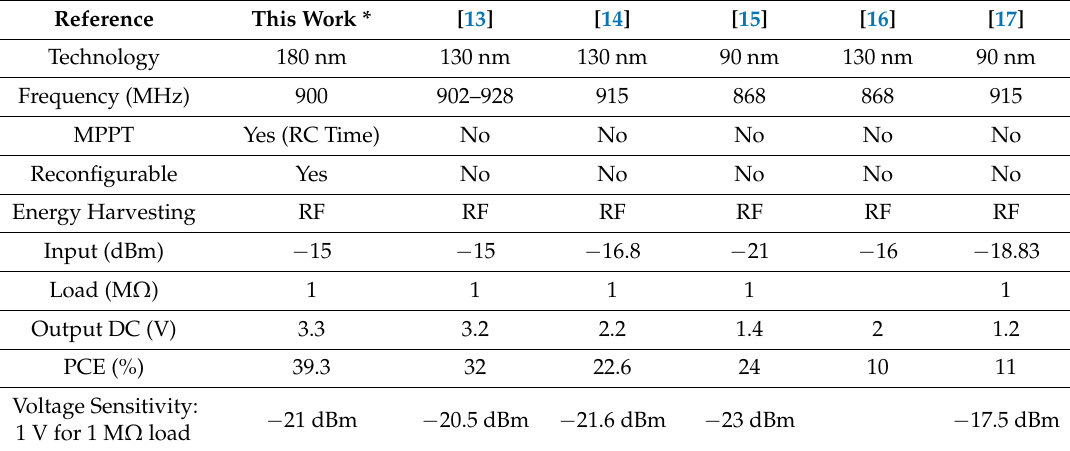
Table 1. Performance summary.